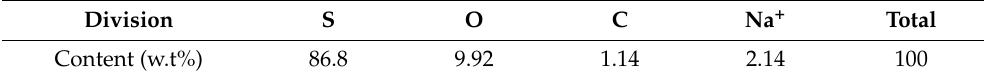
Table 2. The results of quantitative analysis of the constituents using